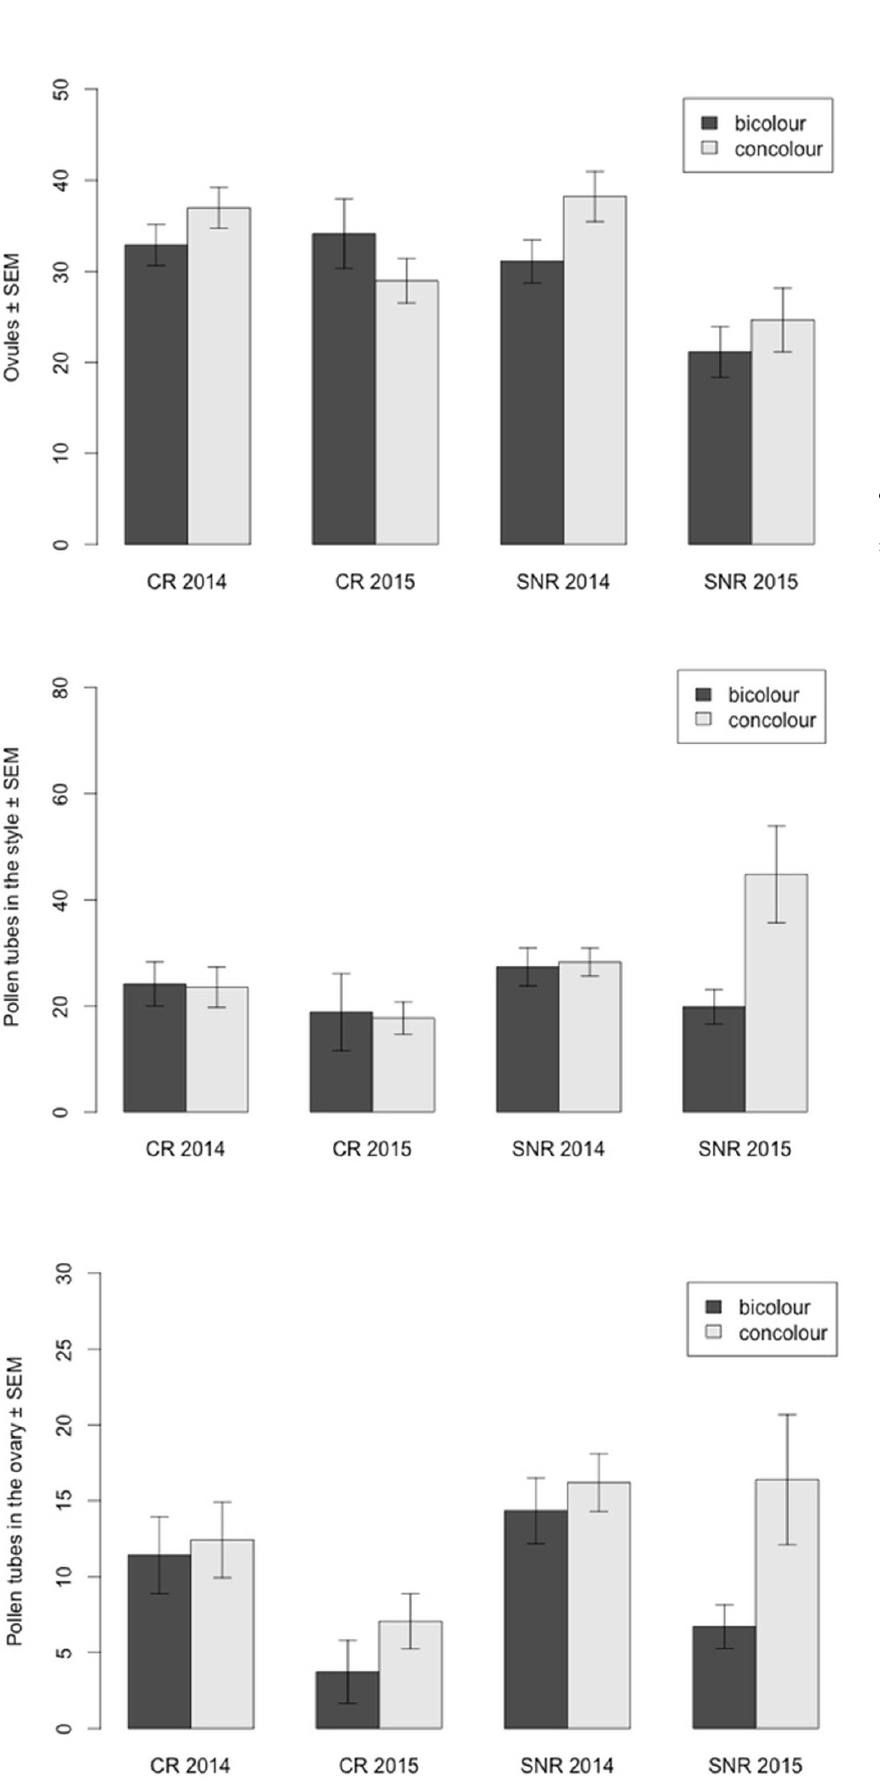
F IGURE 10. Mean number of pollen tubes penetrating ovules in two morphs of Viola pedata at two sites and two years in Missouri, USA.